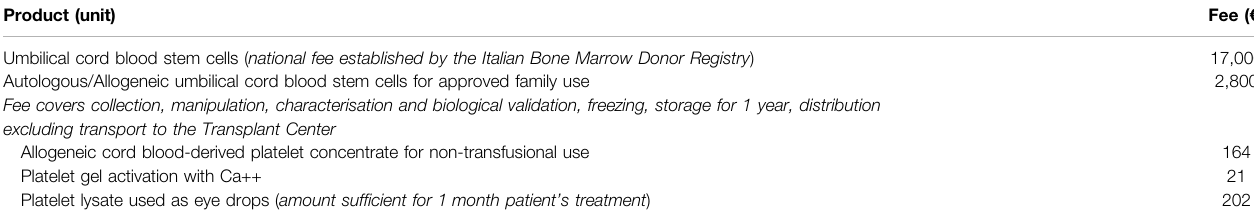
TABLE2| ReimbursementfeesforthetransferofoneunitofCBcomponentbetweenpublichealthservicesappliedatnationallevelinItaly(CentroNazionaleSangue,2021). Product (unit) Fee ( €